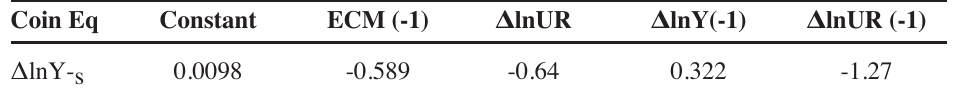
Results of Error Correction